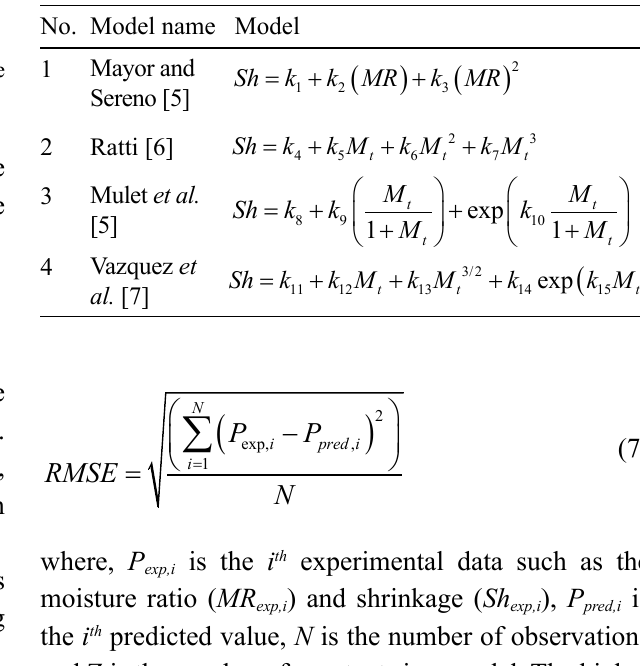
Table 4. Mathematical models applied to shrinkage